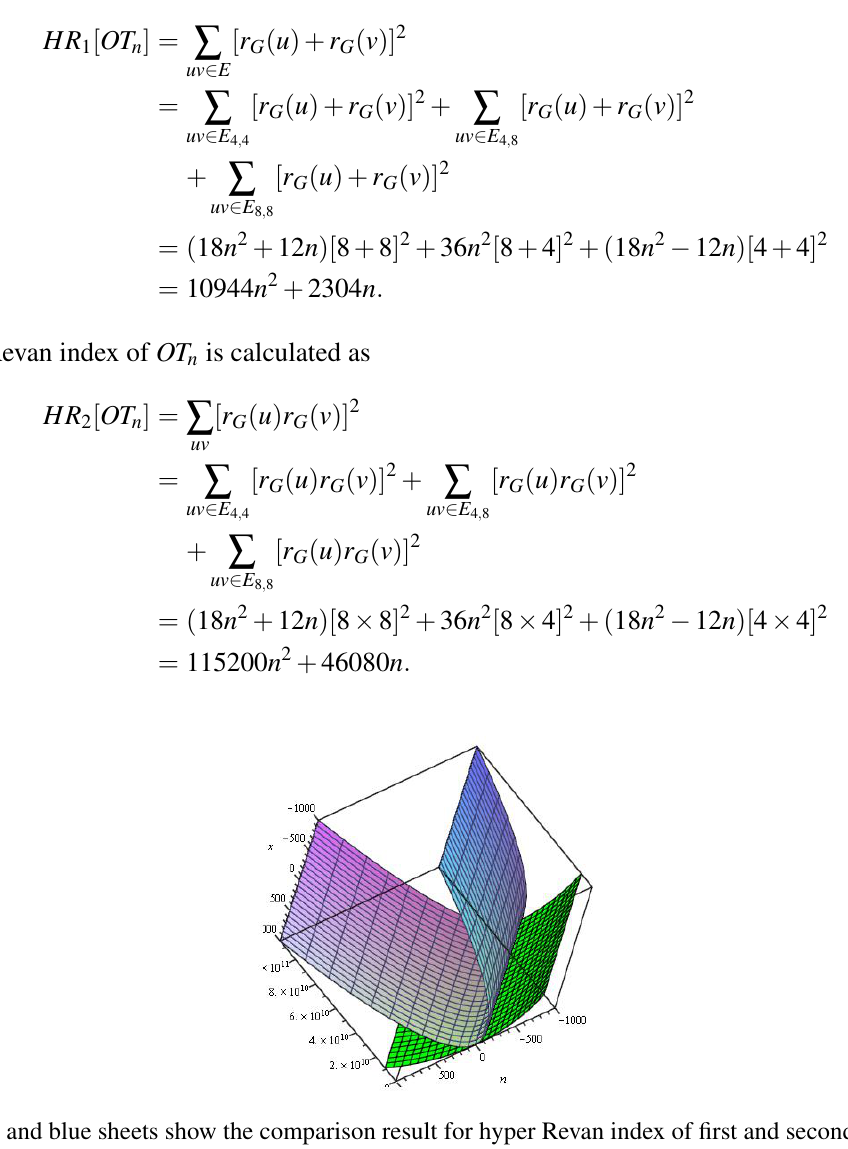
Fig. 3 The green and blue sheets show the comparison result for hyper Revan index of first and second kind Octahedral network OT n